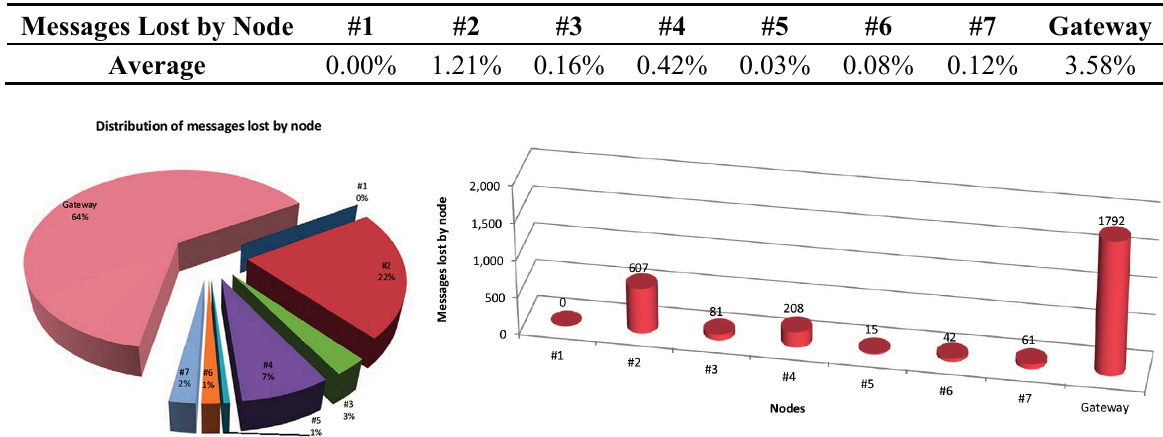
Table 2. Packet error rate (PER) by node.